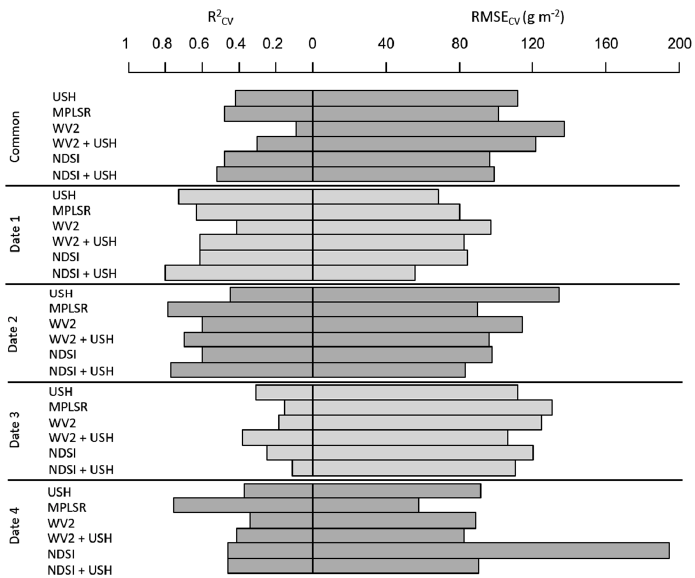
Figure 1. Cross-validation (CV) results for a range of sensor models used for prediction of fresh matter yield (FMY), including exclusive use of ultra-sonic sward height (USH), all hyperspectral wavebands using modified partial least squares regression (MPLSR), normalized difference spectral index (NDSI), and multispectral representation of WorldView-2 wavebands (WV2), as well as models formed from combinations of these sensors.